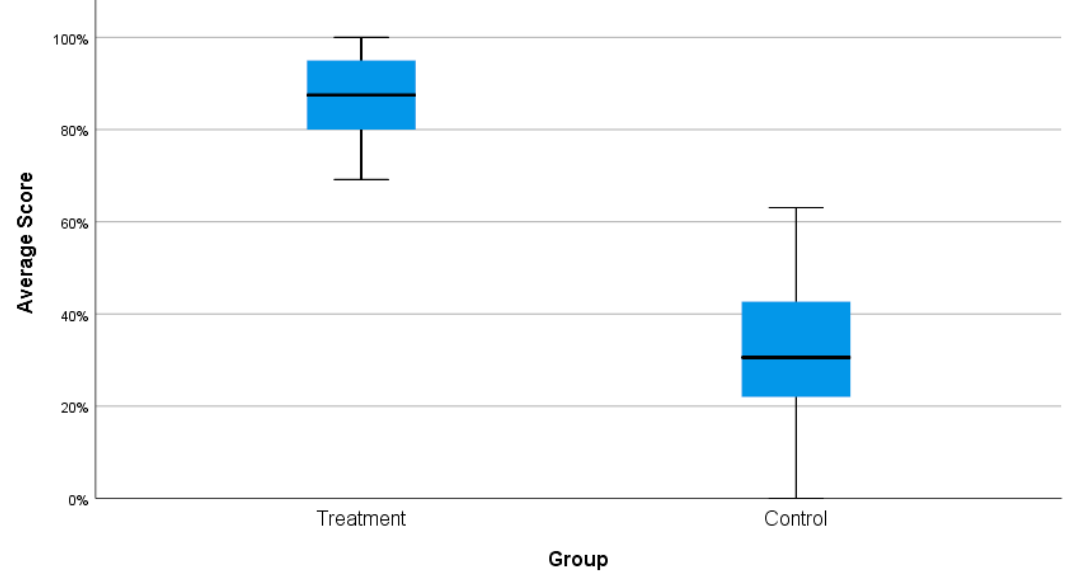
Figure 3. Boxplot of average score.